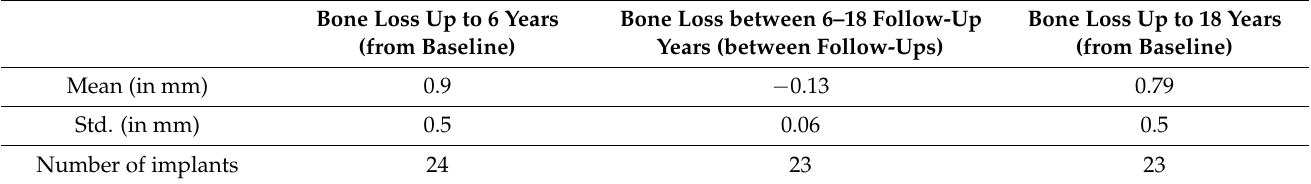
Table 2. Marginal Bone loss of immediate implantation and provisionalization of implants placed at the maxillary esthetic zone from base. Bone Loss Up to 6 Years Bone Loss between 6–18 Follow-Up Bone Loss Up to 18 Years (from Baseline) Years (between Follow-Ups) (from Baseline) Mean (in mm) 0.9 − 0.13 0.79 Std. (in